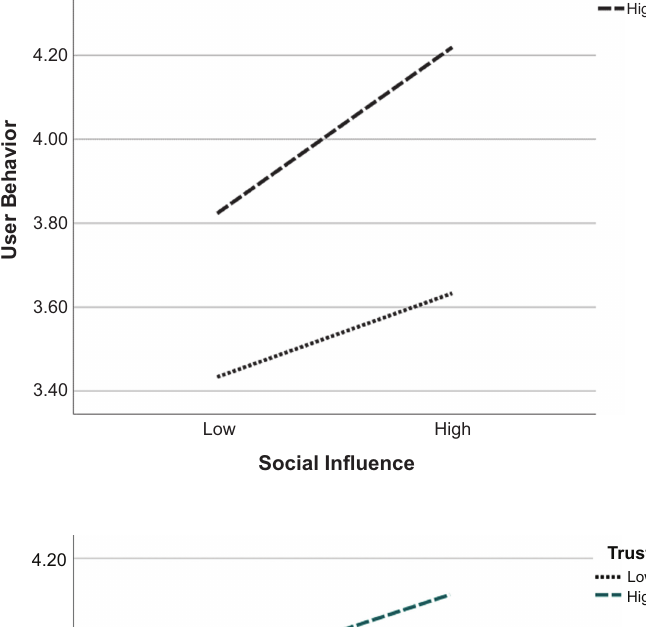
Figure 2. Trustasamoderatorin the relationship between social influence and user